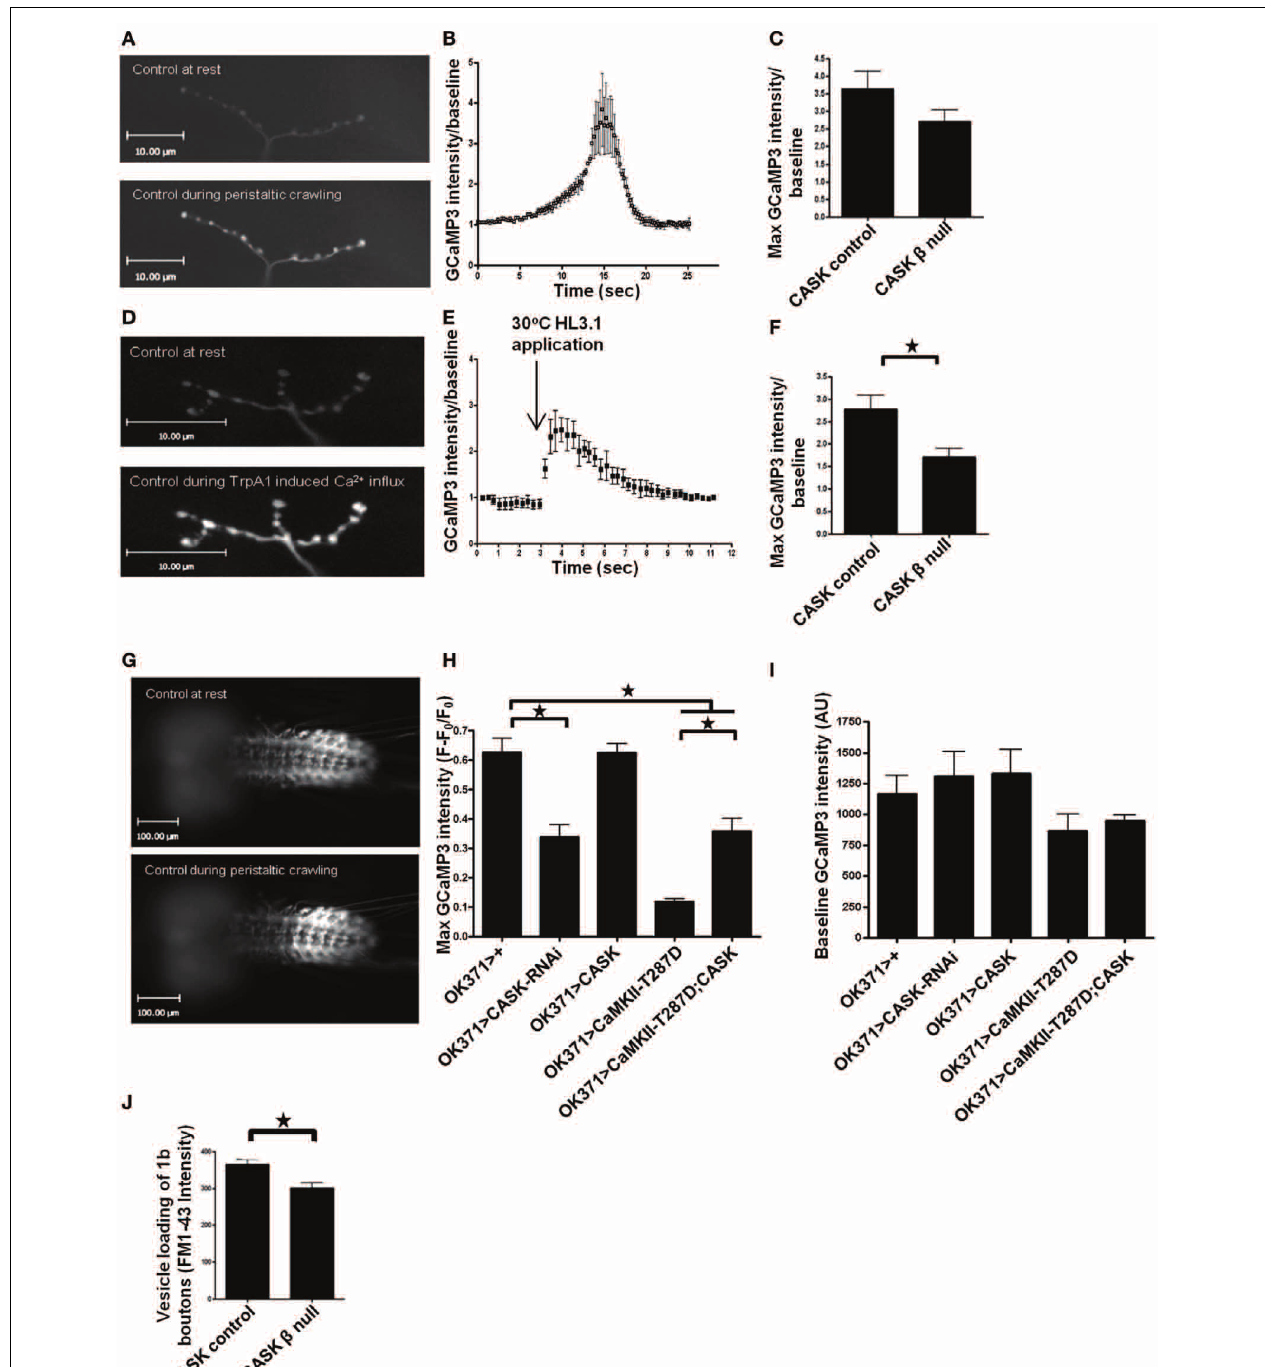
FIGURE 3 | The CaMK-like and L27 domain-containing version of CASK regulates calcium signaling and vesicle cycling. Compared to resting synapses, there is an increase in Ca 2 + signaling during peristaltic crawling, and this increase is reported by the genetically encoded Ca 2 + indicator GCaMP3, which was expressed in motor neurons, as shown in representative images of larval muscle 12 NMJs (A) This increase can be observed as a Ca 2 + -dependent increase in GCaMP3 fluorescence intensity compared to baseline (B) CASK β deletion non-significantly reduced this